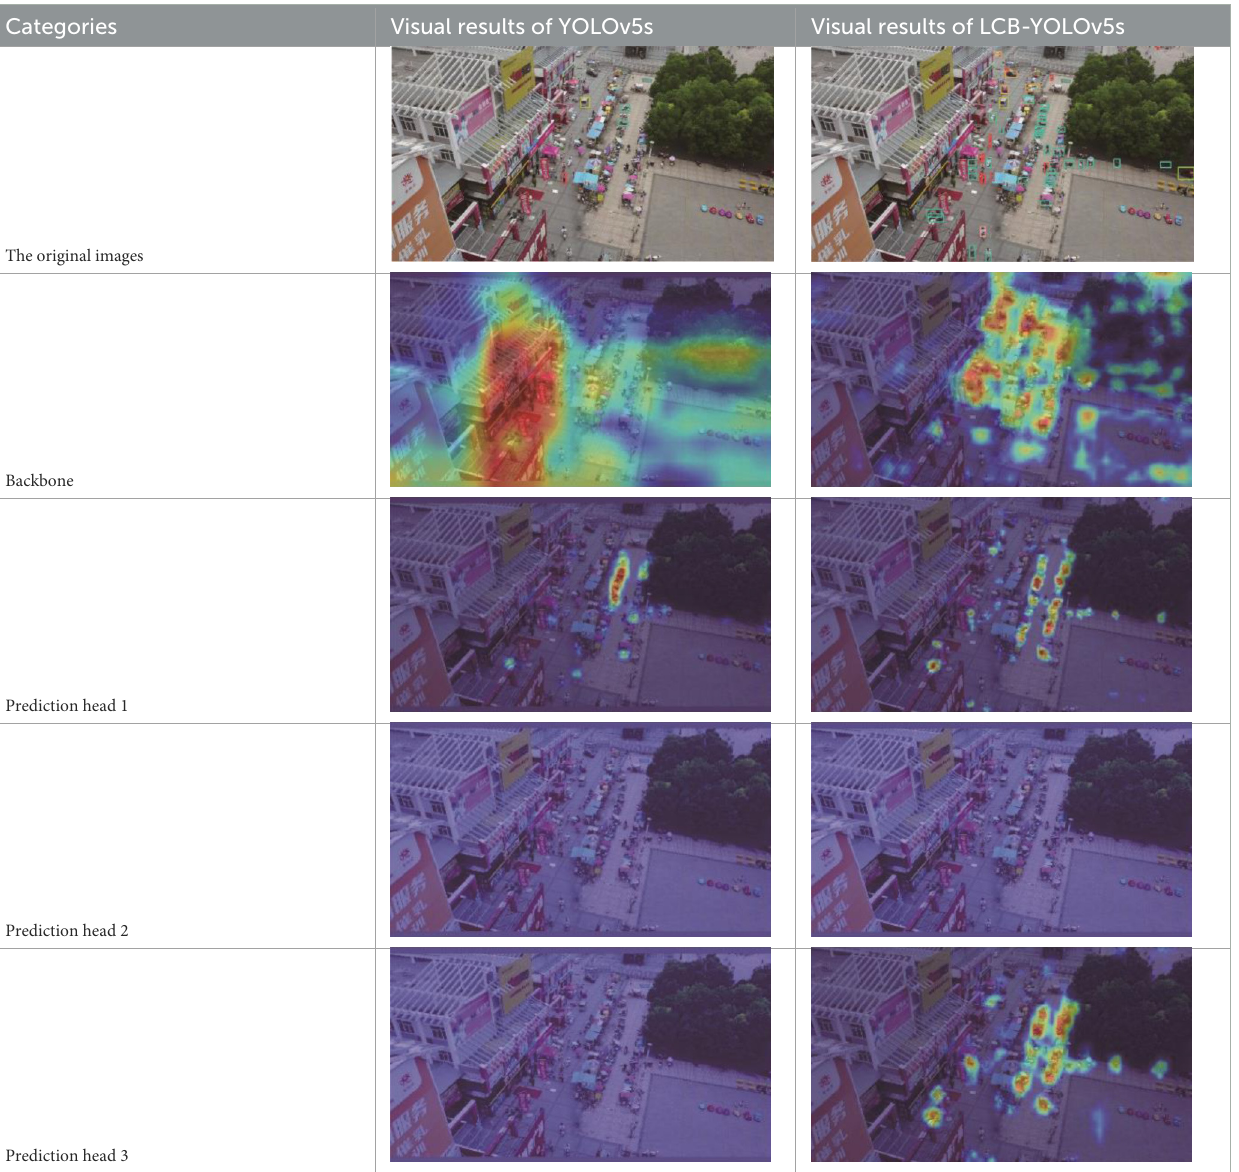
TABLE 5 Visual results of the small target detection on Visdrone2019